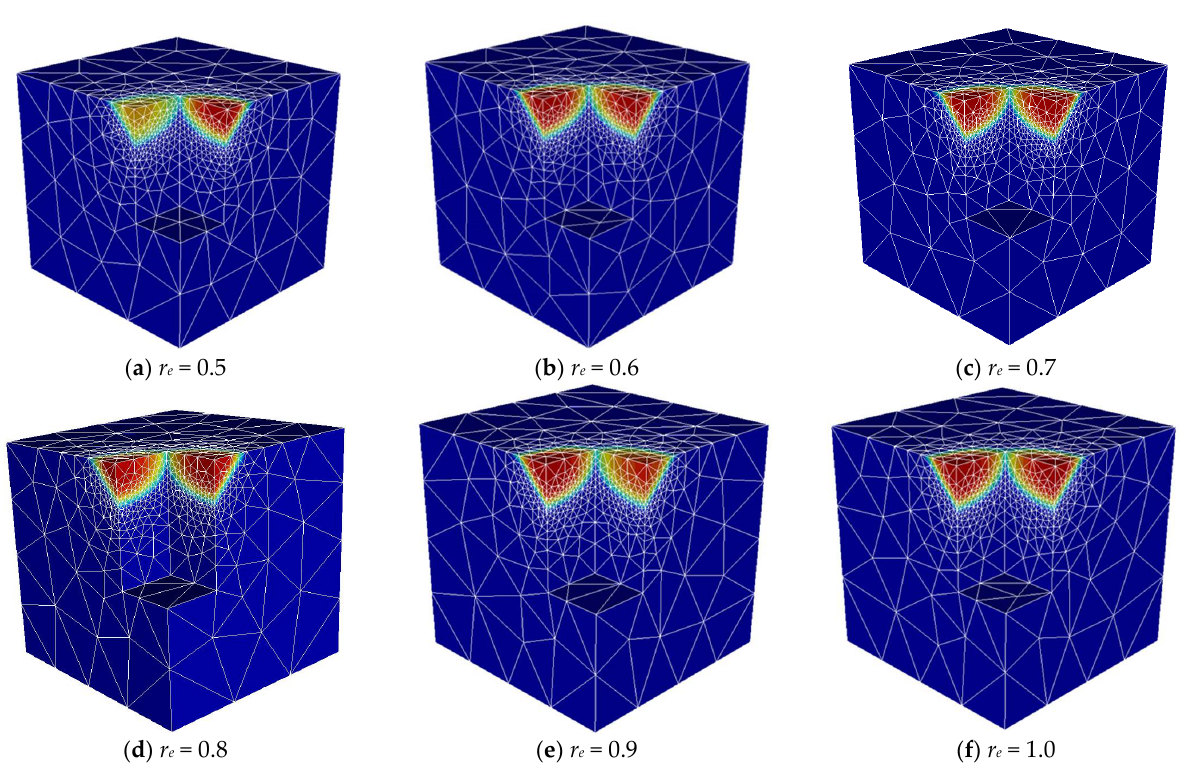
Figure 13. Potential failure mechanisms—effect of r e ( m = 100, H/B = 1, and B/L = 1).